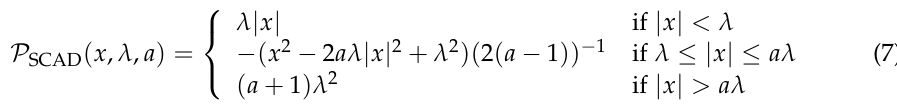
Figure 1. SCAD penalty function